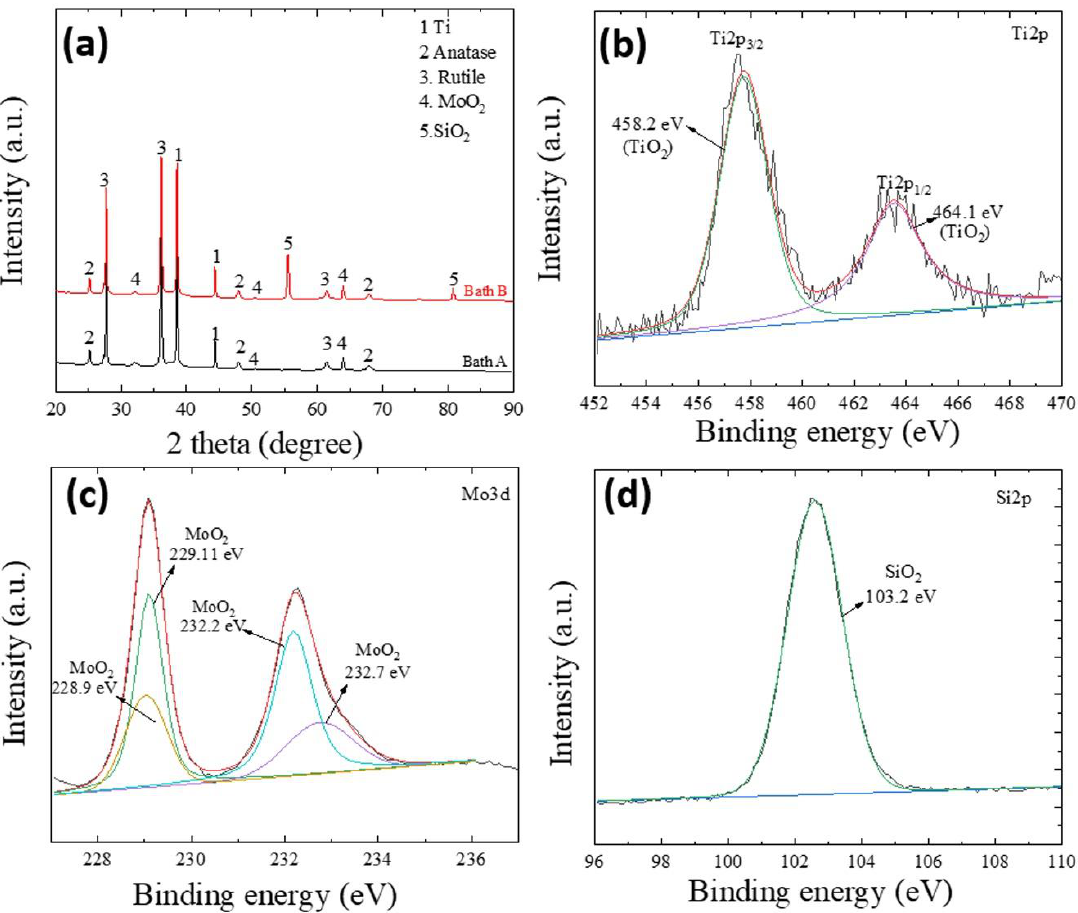
Figure 5. ( a ) XRD patterns of the coatings obtained in Baths A and B. ( b – d ) XPS spectra of Ti2p, Mo3d, and Si2p, respectively, for the coating obtained in Bath B.